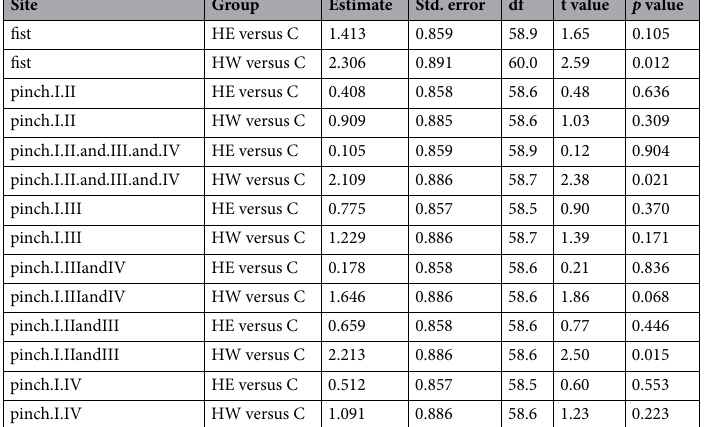
Table 2. Interaction group versus pinch.